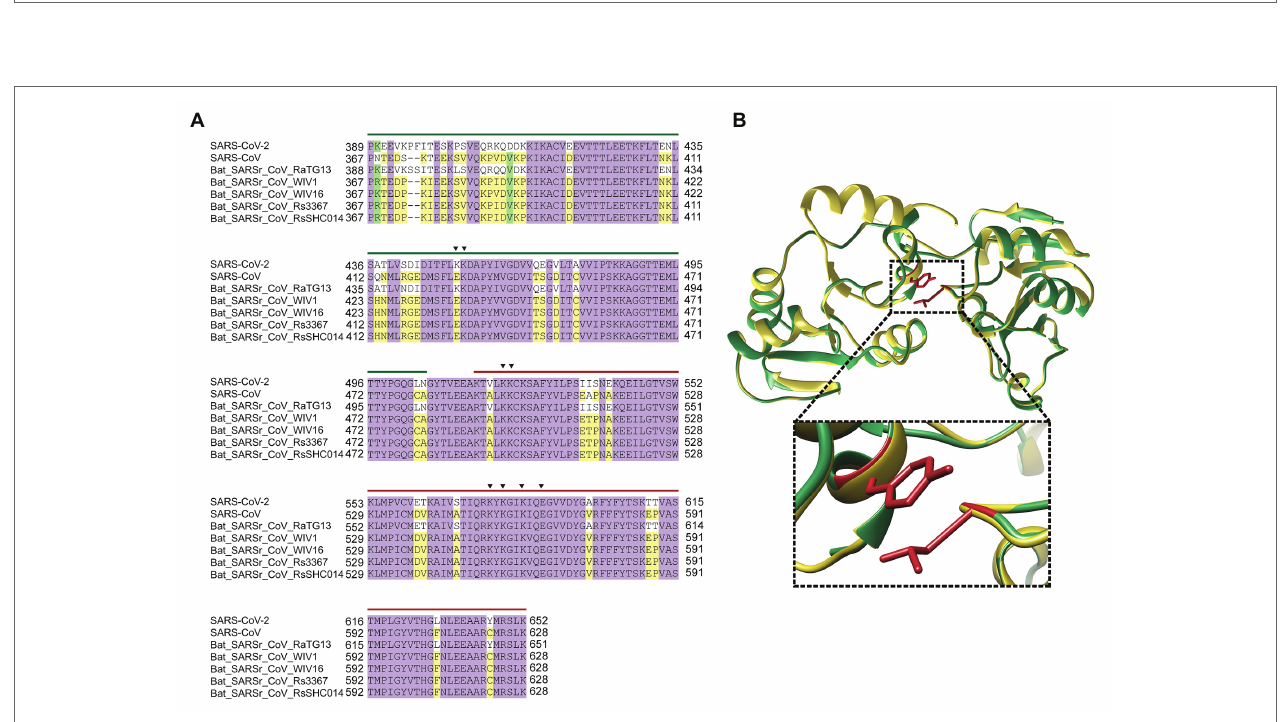
FIGURE 4 | SARS-CoV-2 nsP3 potentially associates with G-quadruplex sequences. (A) Sequence alignment of nsP3 SARS-unique domain (SUD)-M and SUD-N in typical SARSr-CoV. The key amino acids in G-quadruplex binding were indicated in triangle. Green line is SUD-M, while red line is SUD-N. (B) SUD 3D structure superimpose of SARS-CoV and SARS-CoV-2. The enlarged image showed the atom distance between L516 and Y647 in